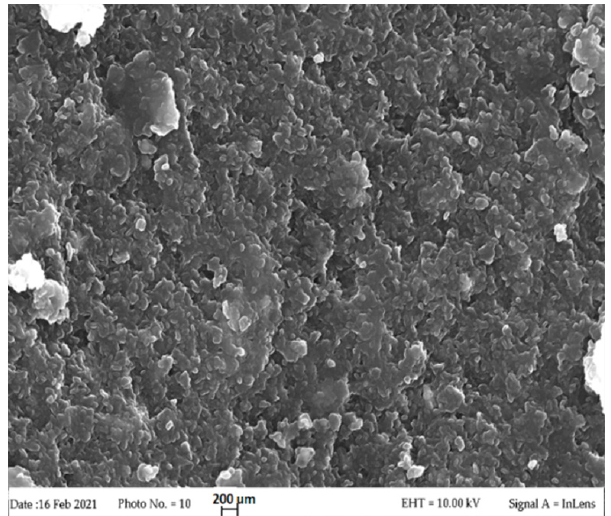
Figure 2. FE-SEM image of the LDH synthesized.